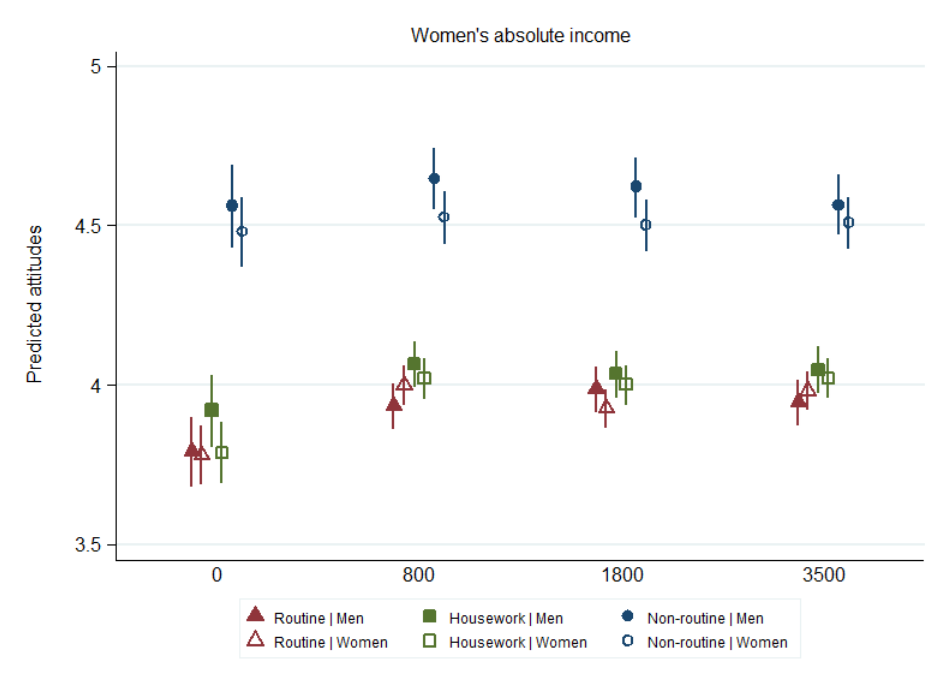
Predicted attitudes towards housework by vignette women’s absolute